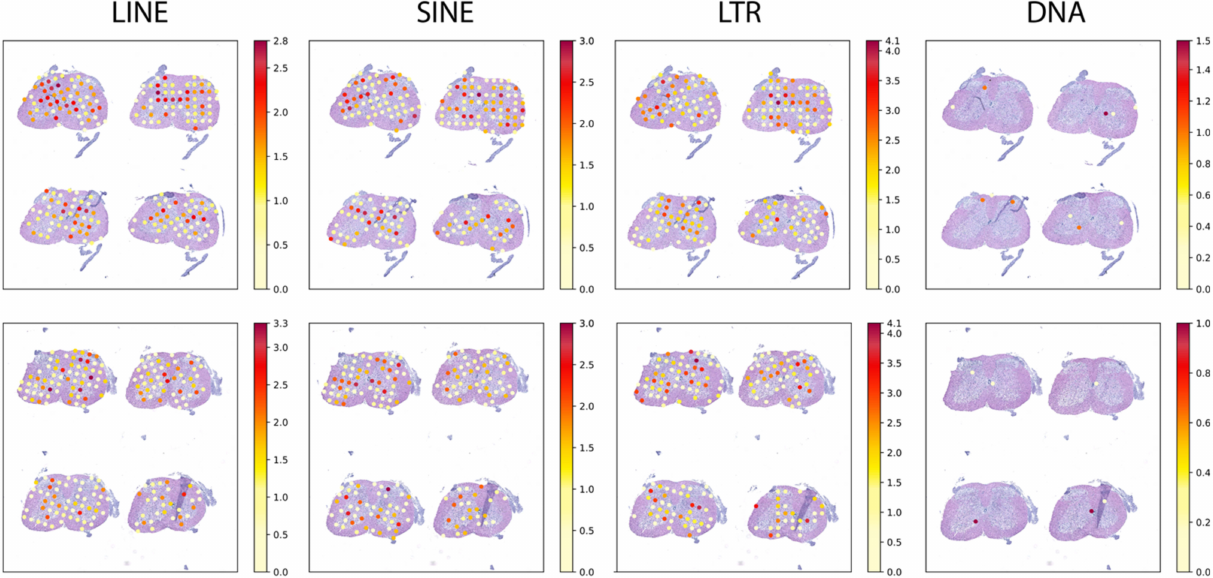
Figure 2. TE expression by class in the p120 SOD1G93A spinal cord. Samples are indicated by their SRA accession to the left, and each TE class is indicated above. Expression levels correspond to log2 normalized counts, with the colour scale indicated at the right of each